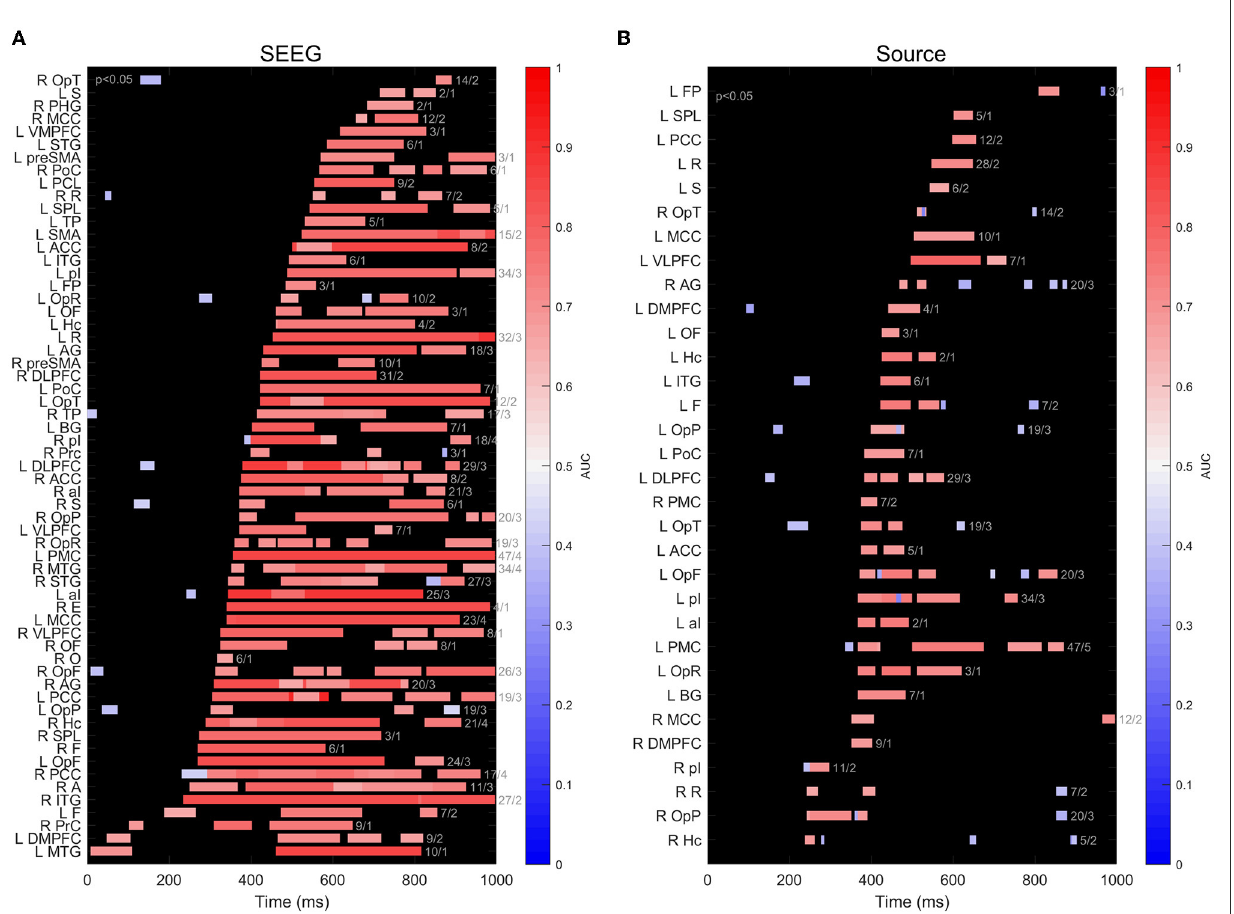
FIGURE6 (A) Timeline of decoding performance significantly different from chance ( p < 0.05) for signals recorded on subsets of intracranial contacts implanted in different brain structures. The color of the bars indicates the maximum value of the AUC score within a cluster. The numbers at the right of each bar indicate the number of sites and number of patients for clusters in each ROI; (B) same as (A) , but for scalp sources calculated at the location of intracranial contacts using